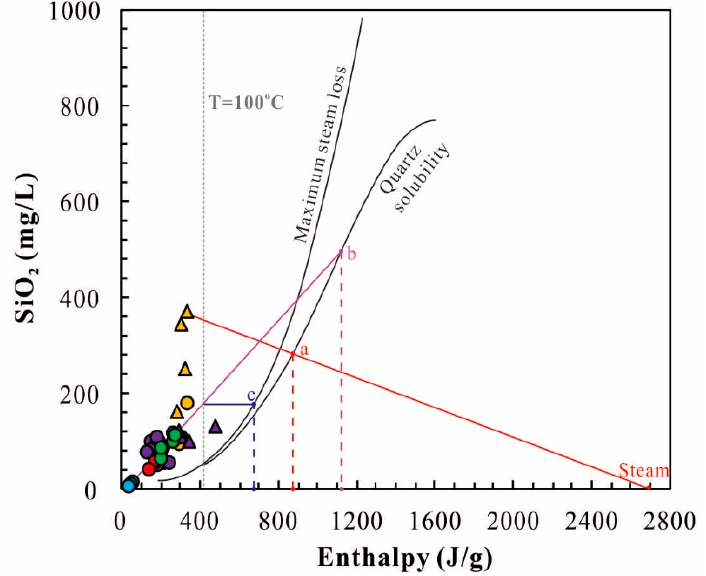
Figure 9. The silica-enthalpy plot of the geothermal waters and cold waters in the XFZ. Legends follow those in Figure 5. those in Figure